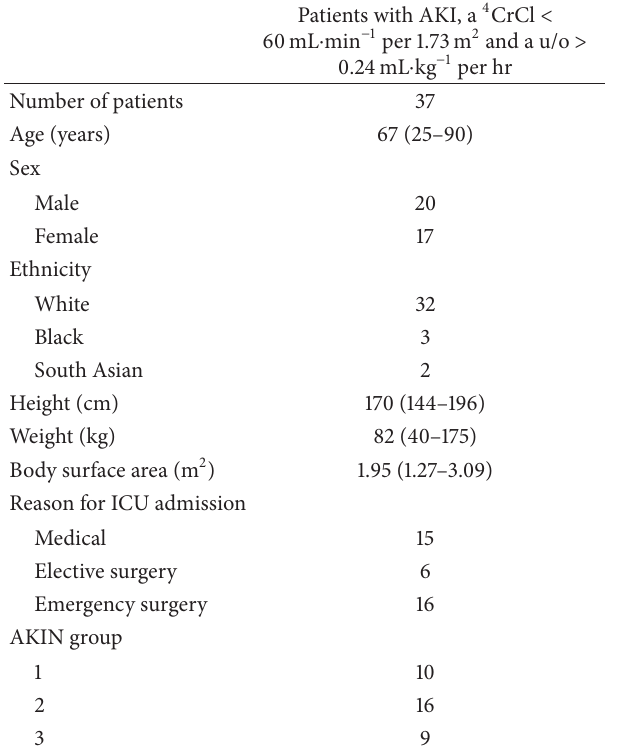
Table 2: Patient demographics (range). Patients with AKI, a 4 CrCl <